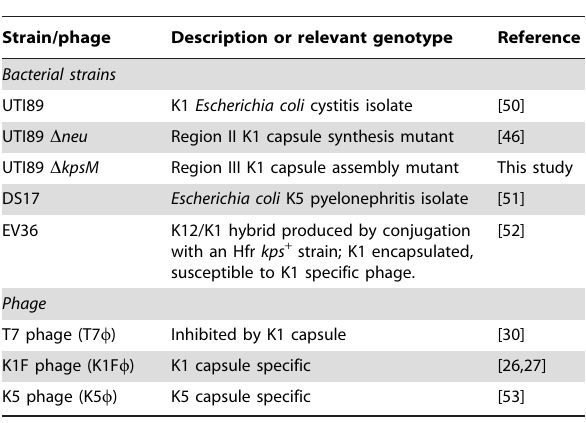
Table 4. Bacteria and phage used in